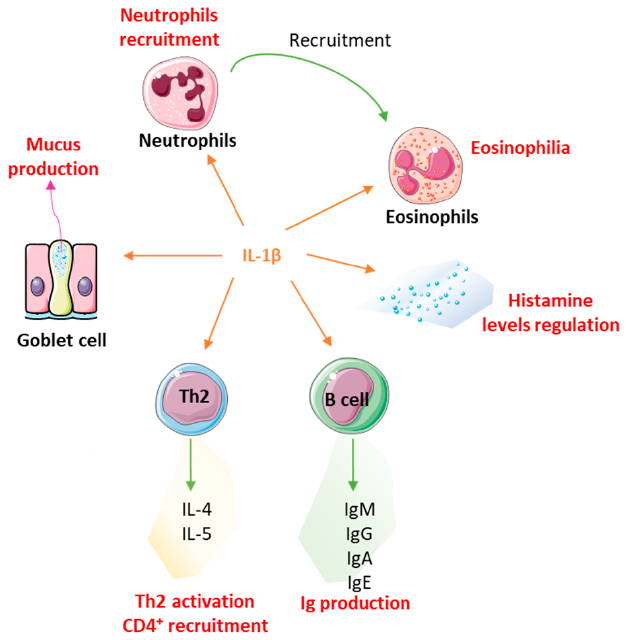
Figure 3. The pro-inflammatory cytokine IL-1 β is implicated in regulating atopic-march-related immune responses. This illustration provides a non-exhaustive representation of the atopic-march- related processes in which IL-1 β is involved, as covered in previous paragraphs. Ig: immunoglobulin.